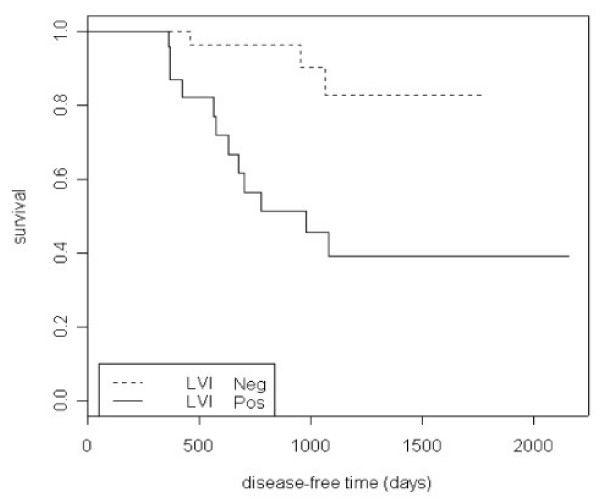
Kaplan-Meiers survival curve shows that presence of LVI is significantly associated with shorter time to recurrence (p = 0.001 Cox model).